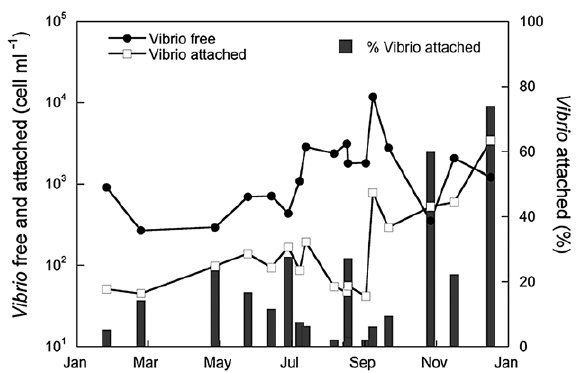
Fig. 5. – Particle abundance and bacteria attached to particles in 2010.